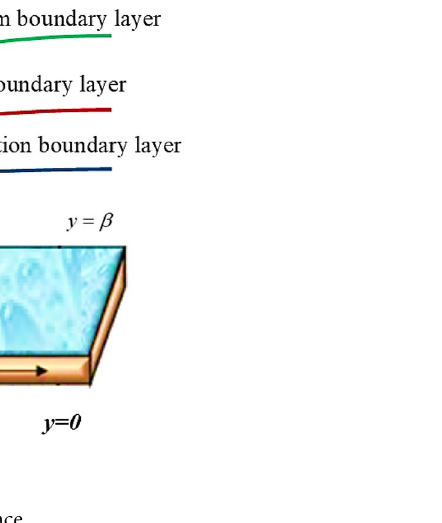
Figure 1. The fluid flow over a stretching